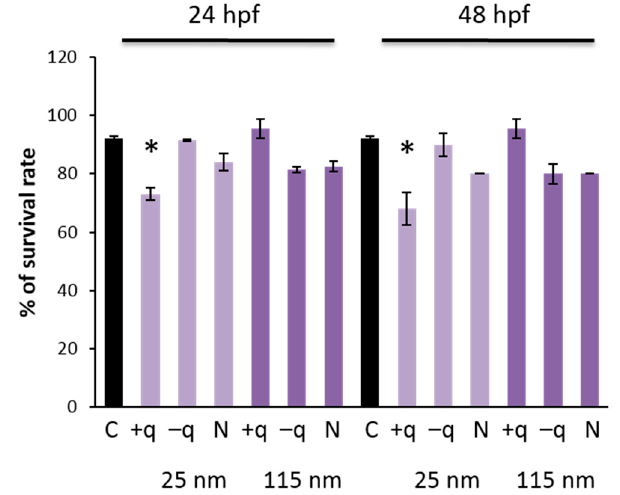
Figure 6. Survival rate at 24 and 48 hpf in zebrafish embryos exposed to 100 mg/L of 25 or 115 nm SiO 2 NPs with different surface charges after chemical removal of chorion at 6 hpf. Data are represented as mean ± SD. * p < 0.05 compared with the control (ANOVA followed by Dunnett’s multiple comparison test).